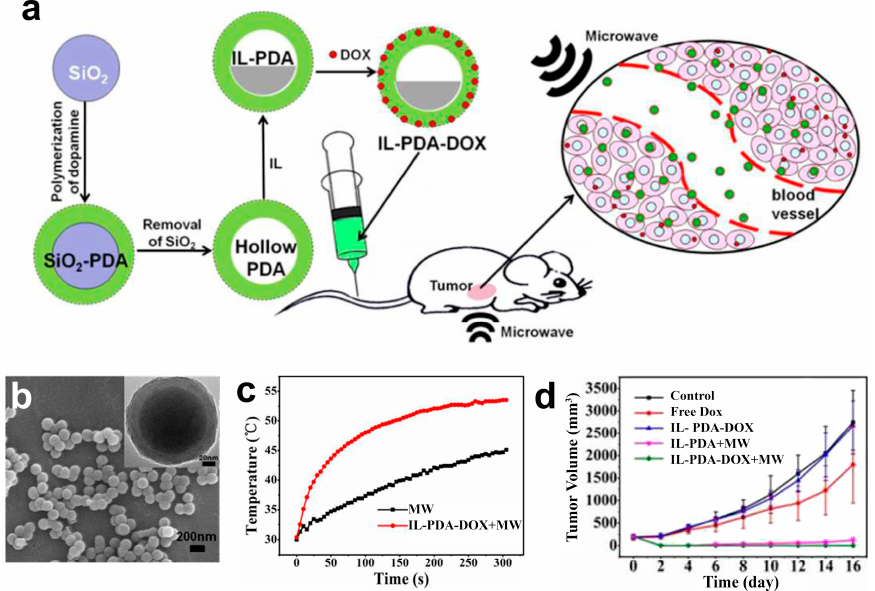
Figure 14. ( a ) Schematic illustration of the synthesis process of IL- PDA-DOX nanocomposites for combined chemotherapy and microwave-induced hyperthermia-therapy of cancer. ( b ) SEM and TEM images of IL-PDA-DOX nanocomposites. ( c ) Temperature rising curves of IL- PDA-DOX